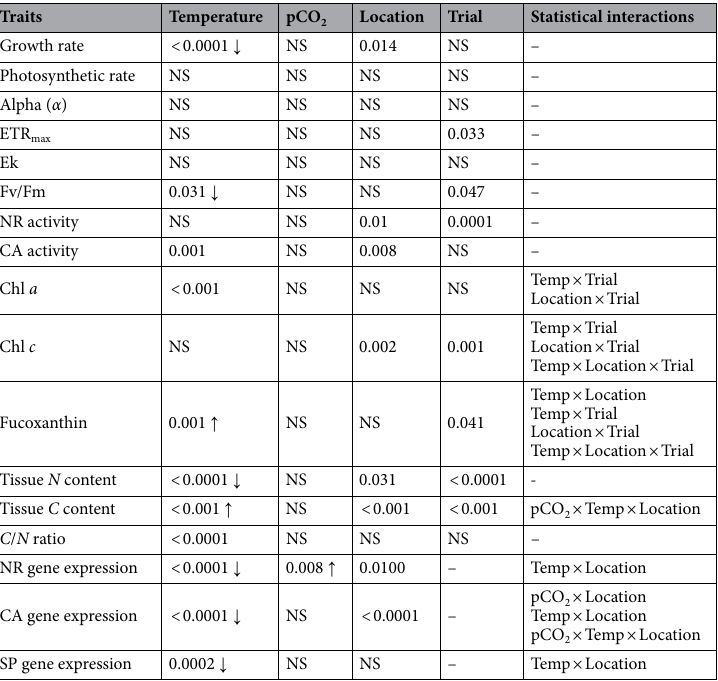
Table 1. Physiological, biochemical and molecular responses of Macrocystis pyrifer a juveniles to changes in temperature and pCO 2 across locations and trials. NS represents no significant effect, p values < 0.05 represent significant effect, “ ↑ ” represents increase and “ ↓ ” represents decrease.